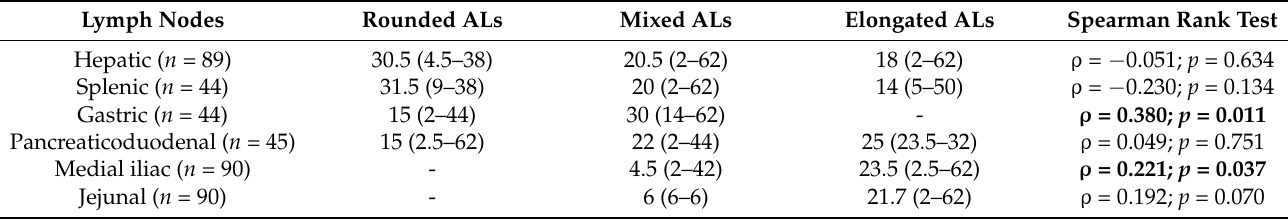
Table 2. Median and range (within parentheses) values of BW (kg) according to different shapes in the lymph nodes examined. Data were stratified by localization.